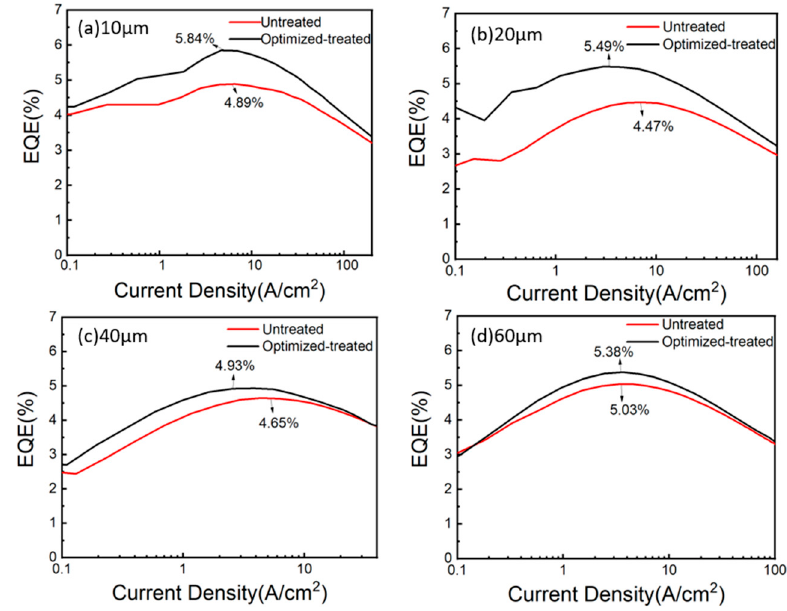
Figure 5. External quantum efficiency for ( a ) the 10 μ m Micro-LED pixel; ( b ) the 20 μ m Micro-LED pixel; ( c ) the 40 μ m Micro-LED pixel; and ( d ) the 60 μ m Micro-LED pixel.